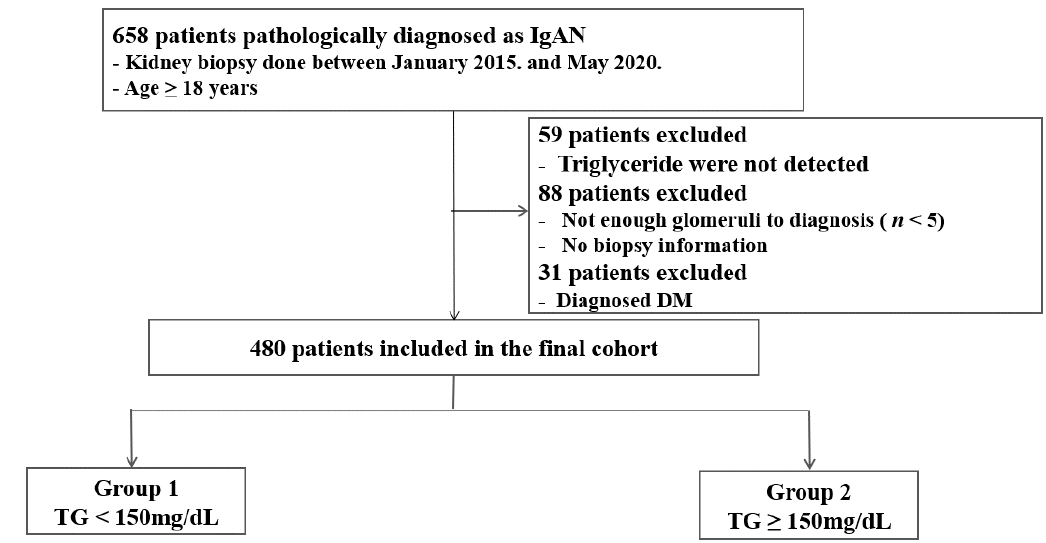
Figure 1. Flow diagram for study population. Abbreviation: IgAN, IgA nephropathy; DM, diabetes mellitus; TG, tri- glyceride.